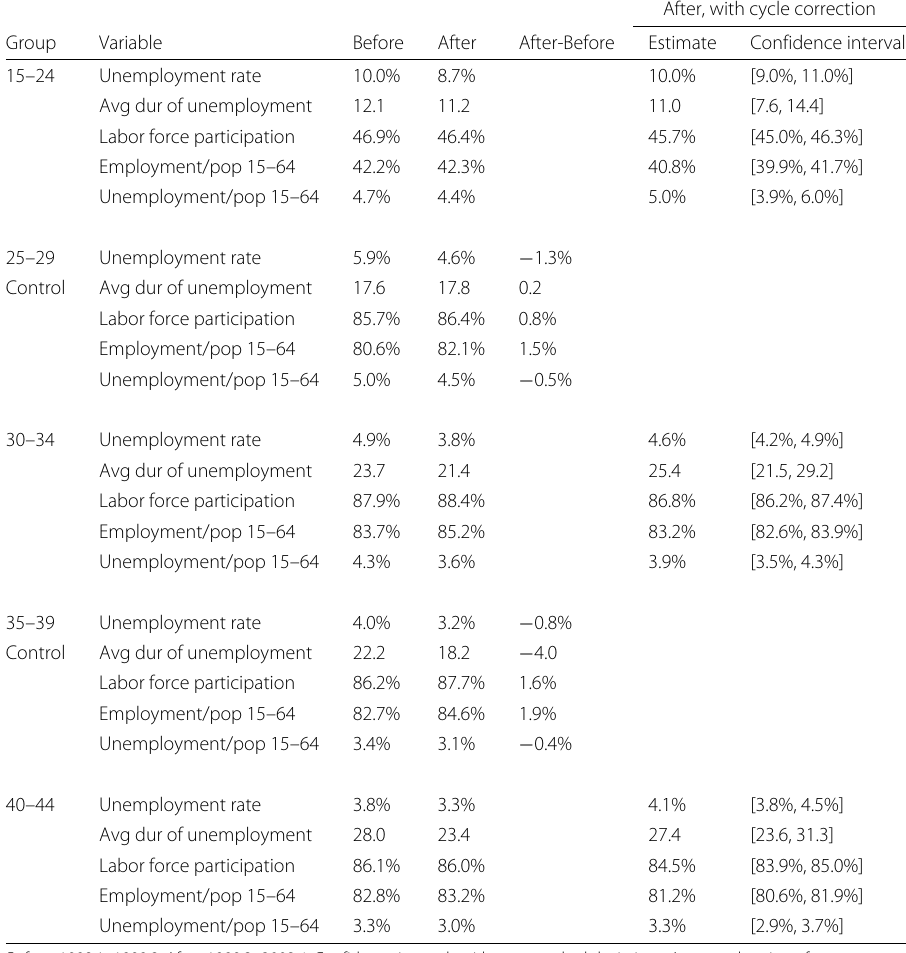
After, with cycle correction